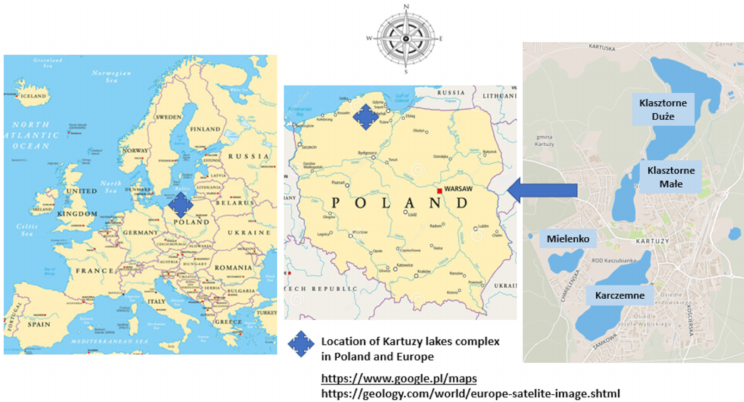
Figure 1. The position of Kartuzy lake complex in Poland and Europe. Mielenko (1.9 m) and Karczemne (3.2 m) are shallow, polymictic lakes that mix to the bottom throughout the year. The basins of both lakes are semicircular (DI—0.68, DI—0.62) and poorly seated in the ground, which is depicted by their relative depths: 0.0068 and 0.0050. The following two reservoirs, Klasztorne Małe (20.0 m) and Klasztorne Du˙ze (8.5 m)